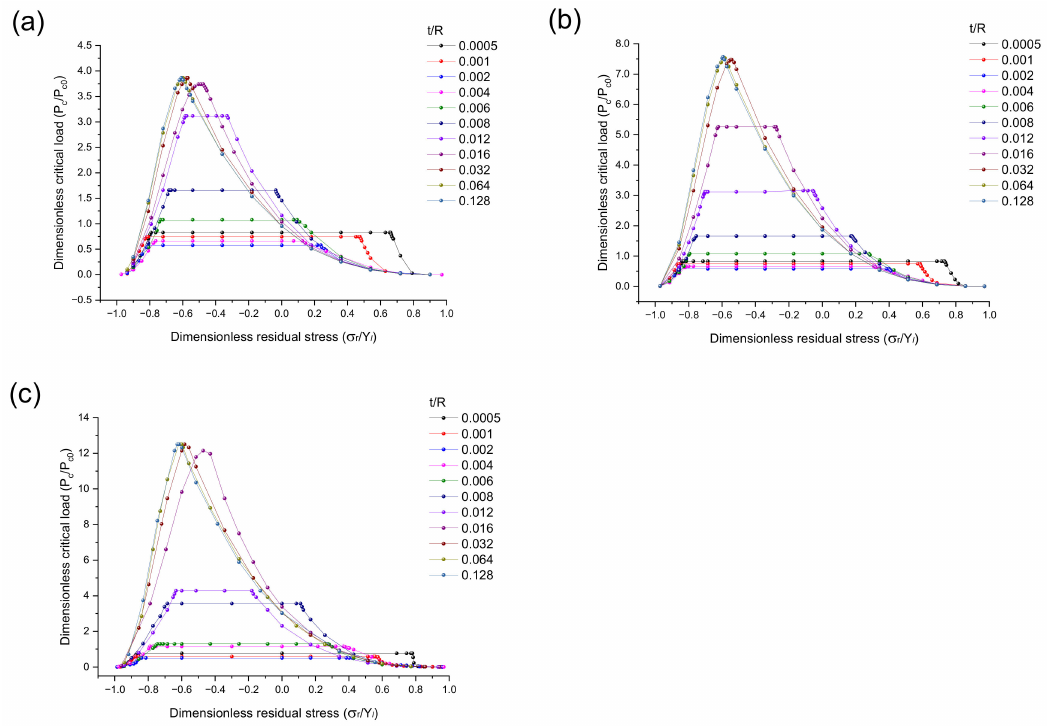
Figure 7. Dimensionless critical load versus dimensionless residual stress and dimensionless thick- ness for surface layer/substrate system pressed by a rigid hemisphere. ( a ) E s = 200 GPa, E l = 400 GPa, Y s = 600 MPa, Y l = 952 MPa. ( b ) E s = 200 GPa, E l = 400 GPa, Y s = 600 MPa, Y l = 1200 MPa.